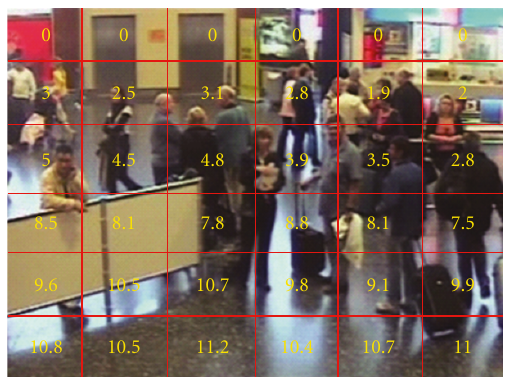
Figure 15: Sample of average velocity map.